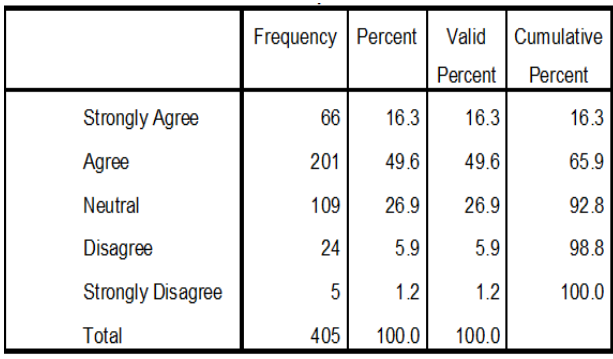
Figure 9. The profits of the company are reflected in the optimistic behaviour of the senior management